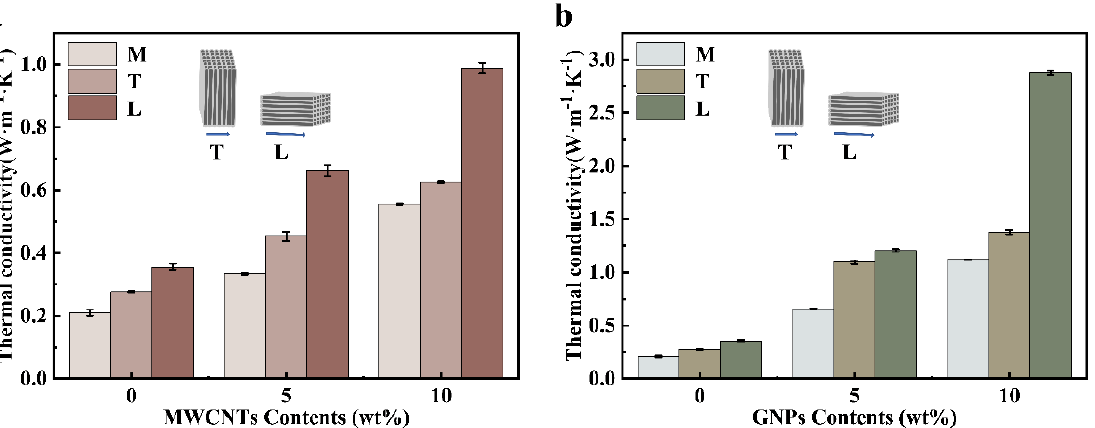
Figure 5. Single component thermal conductivity of ( a ) pure TPU, 5 wt% MWCNTs-TPU, 10 wt% MWCNTs-TPU; ( b ) pure TPU, 5 wt% GNPs-TPU, 10 wt%